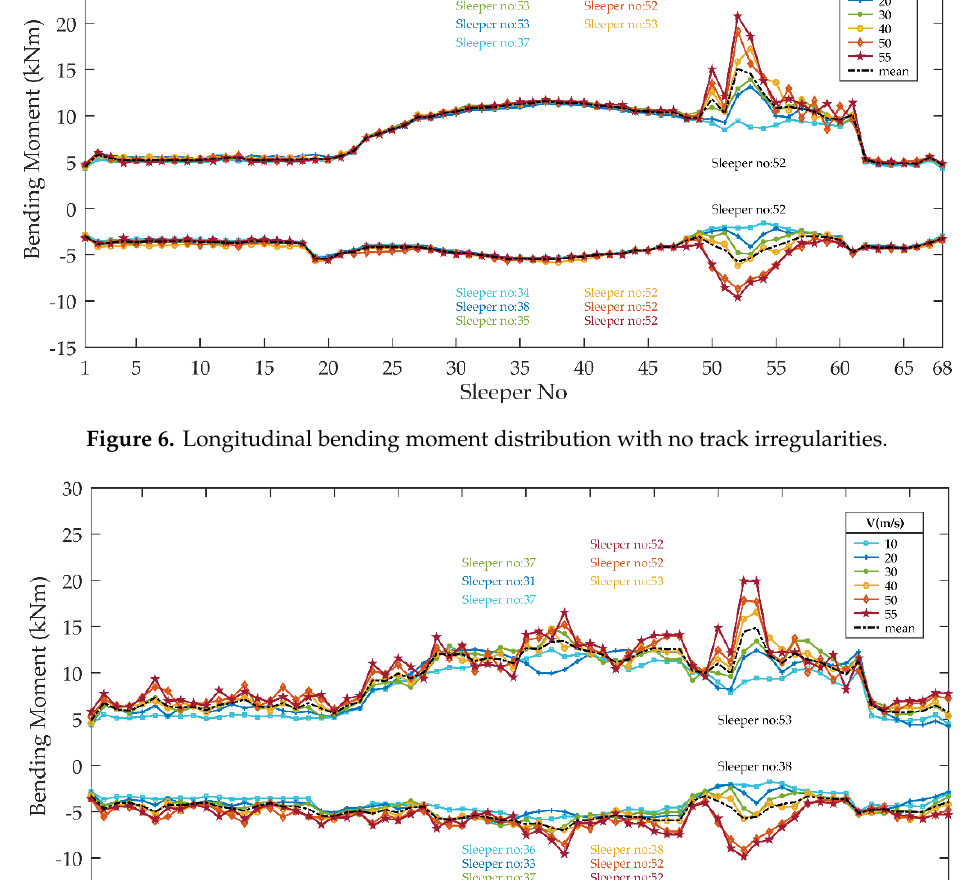
Figure 7. Longitudinal bending moment distribution with track irregularities.